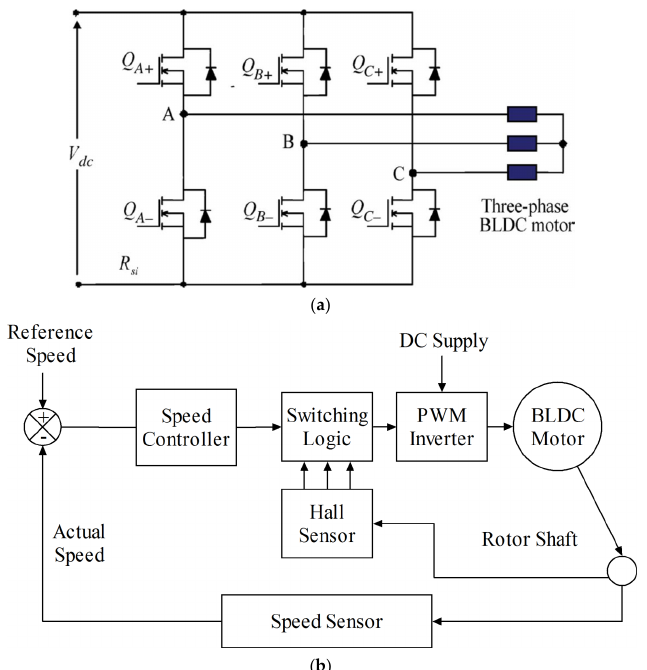
Figure 1. ( a ) Typical inverter systems for a BLDC motor, ( b ) Brushless DC motor’s speed control system.